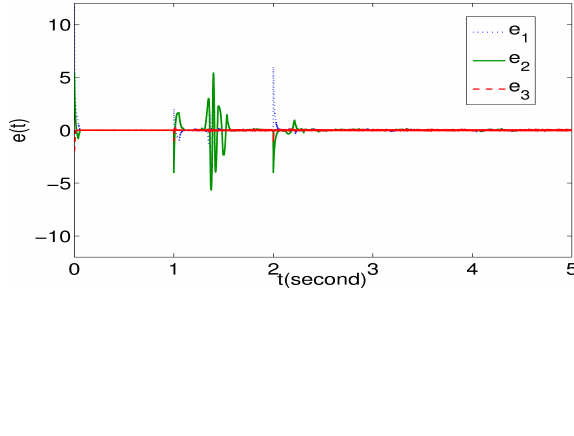
Fig. 2. Time response of O (cid:26)